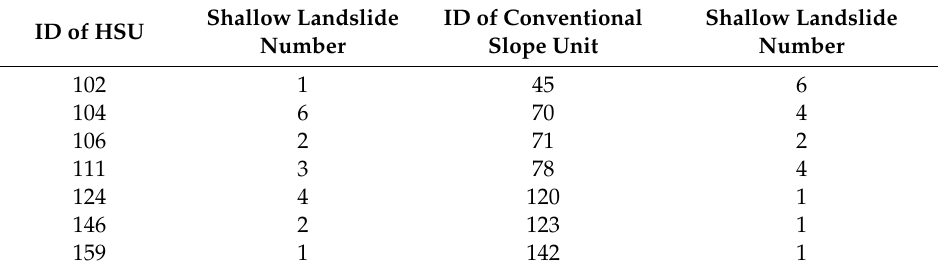
Table 2. The shallow landslide contained in slope units.